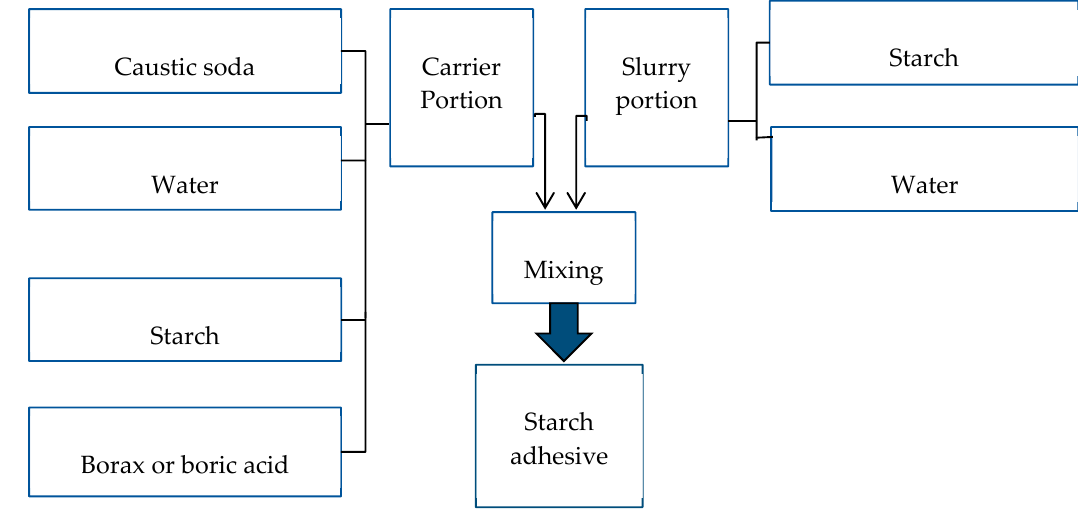
Figure 2. The Stein Hall process.